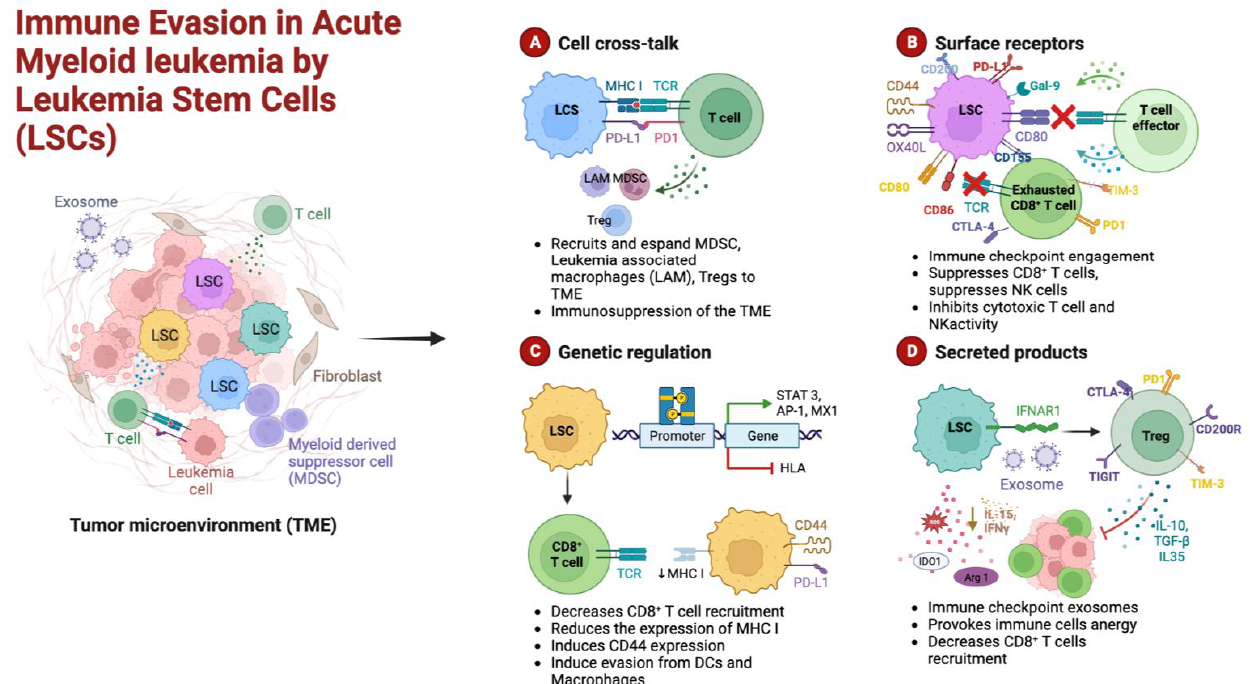
Figure 1. Schematic representation of the cellular mechanisms of anti-tumor surveillance escape in AML. ( A ) Cellular cross-talks: leukemic stem cells (LSCs) and T cells direct interaction, through major histocompatibility complex (MHC) and over-expressed immune checkpoint ligands (PD-L1), causes functional defects in anti-tumor immunity. LSCs induce the expansion of immunosuppressive cells such as regulatory T cells (Tregs), myeloid-derived suppressor cells (MDSCs), and leukemia-associated macrophages (LAMs). ( B ) Surface receptors: LSCs can hamper both T- and NK-cell effector functions by aberrantly overexpressing inhibitory ligands such as CD155, CD80, PD-L1, and galectin-9 (Gal-9). ( C ) Genetic regulation: the activation of immune checkpoint pathways, such as PD-1 and cytotoxic T-lymphocyte-associated protein 4 (CTLA-4), and the expression of CD44, a cell- adhesion molecule that has been shown to be involved in the promotion of resistance to drug-induced apoptosis, prevent the appropriate anti-tumor immunity. Moreover, epigenetic mechanisms may result in the downregulation of MHC expression in AML cells, leading to immune escape and relapse in AML. ( D ) Secreted products: LSCs release inhibitory mediators, either as soluble molecules or as a component of exosomes; furthermore, induced immune cell (Tregs, CD8+ T cells) anergy lowers the levels of inhibitory cytokines. Among these factors that alter the bone marrow microenvironment milieu, a relevant role is played by indoleamine 2,3-dioxygenase (IDO), interferon-gamma (IFN- γ), transforming growth factor beta (TGF- β), arginase 1 (Arg 1), and interleukin 10 and 15 (IL-10 and IL-15). Figure created in Biorender.com.